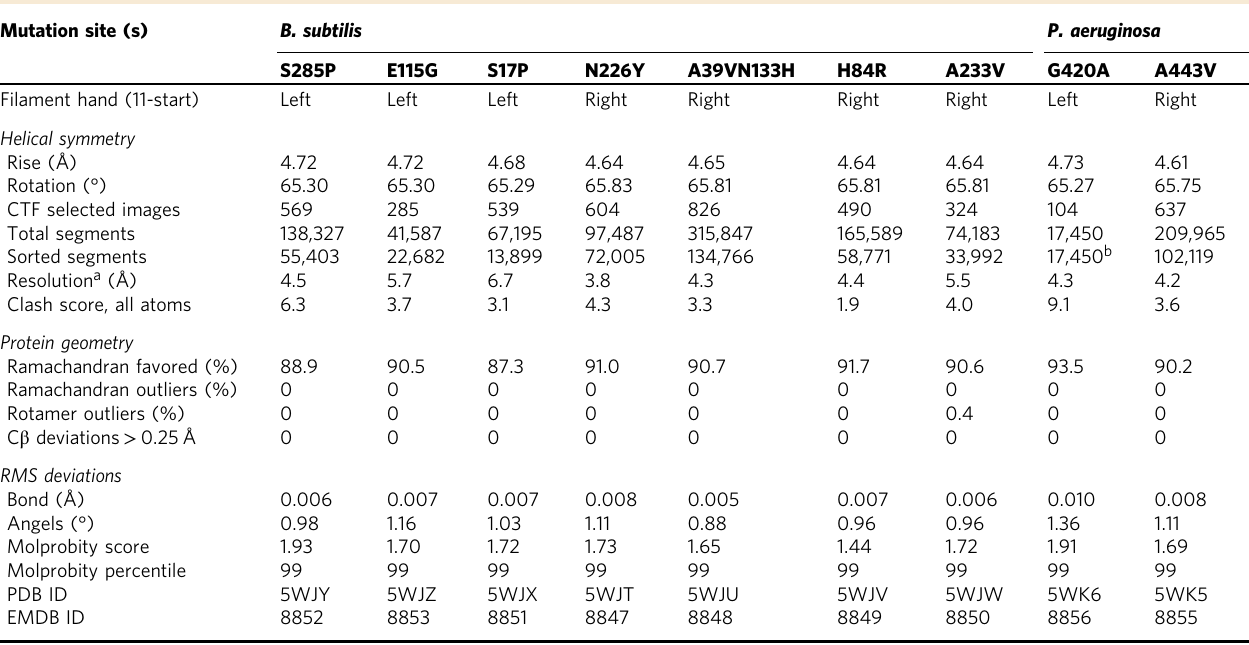
Table 1 Re fi nement statistics for the fl agellar fi lament models Mutation site